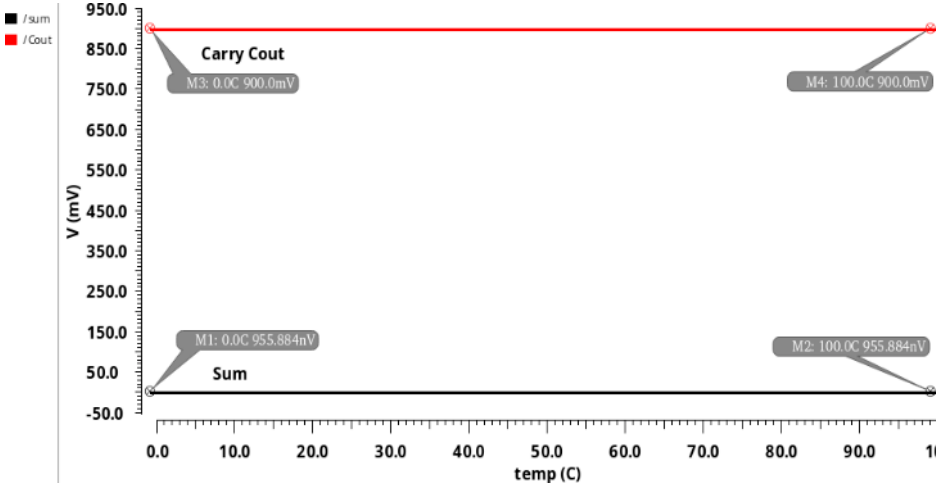
Figure 14. Temperature stability of 13T AA design.